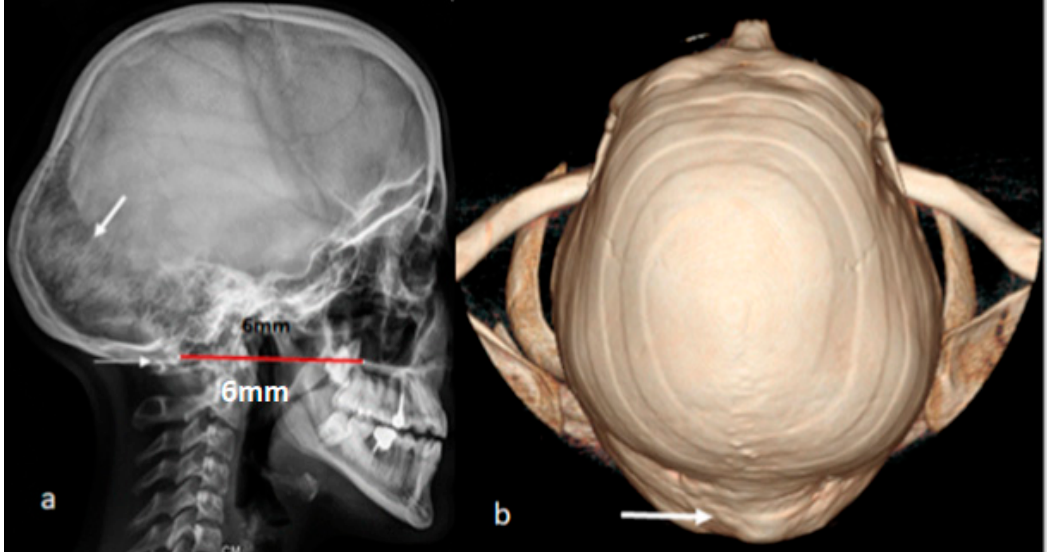
Figure 2. ( a , b ): Lateral skull radiograph of an 18-year-old girl with OI type IV B showing a massive downward redundancy of the occipital area along the lambdoid sutures (the occipital part of the skull that contains the occipital cerebrum looks like a bag of worms, arrow) in connection with progressive softening of the lambdoid area. The latter was obviously overwhelmed with an abundancy of wormian-like bones. Chamberlain’s line indicates 6 mm bulging of the odontoid into the brain stem. The severity of the upward bulging of the dens can be easily assessed via the semi-translation of the atlas onto the occiput (arrow), which resulted in atlanto-axial dislocation. Her genotype demonstrated homozygous mutation in COL1A2 (p.G322S) ( a ). Three-dimensional reconstruction CT scan superior view of a 23-year-old male patient with OI type IVB showing massive bulging of the occiput, causing tremendous disfigurement of the cranial anatomical structures. His genotype demonstrated mutation in COL1A2 c.2827G>A ( b ).